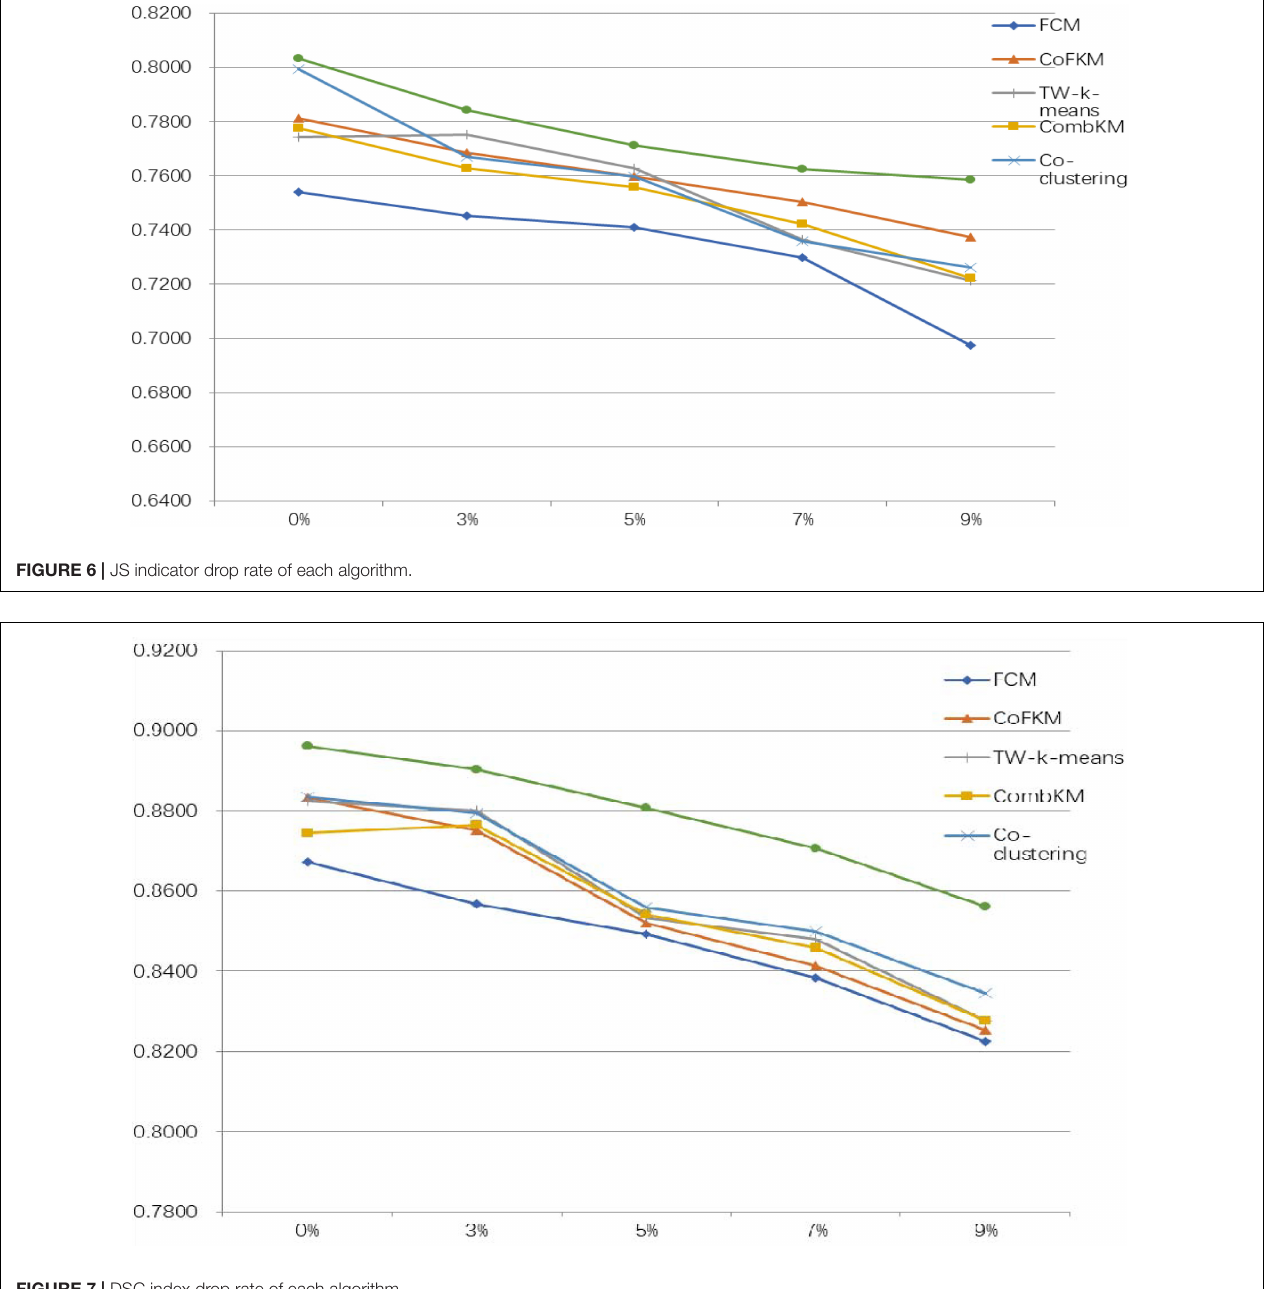
FIGURE 7 | DSC index drop rate of each